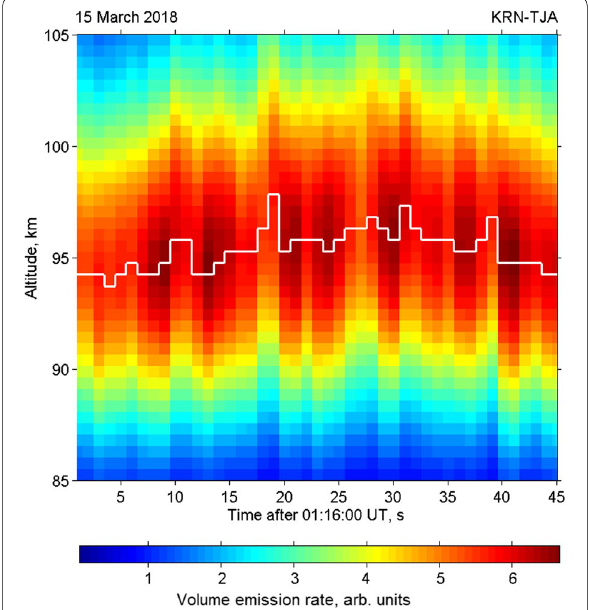
Fig. 3 Altitude vs time diagram taken in the vertical plane passing through part of the profile in Fig. 2 containing the arc examined. The white step‑like line shows the time variation in the altitude of maximum luminosity